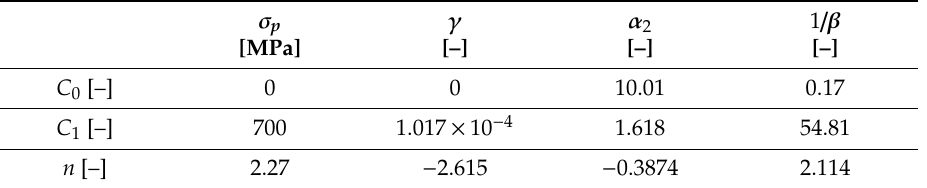
Table 6. Density-dependent hardening constants for the XPS foams.